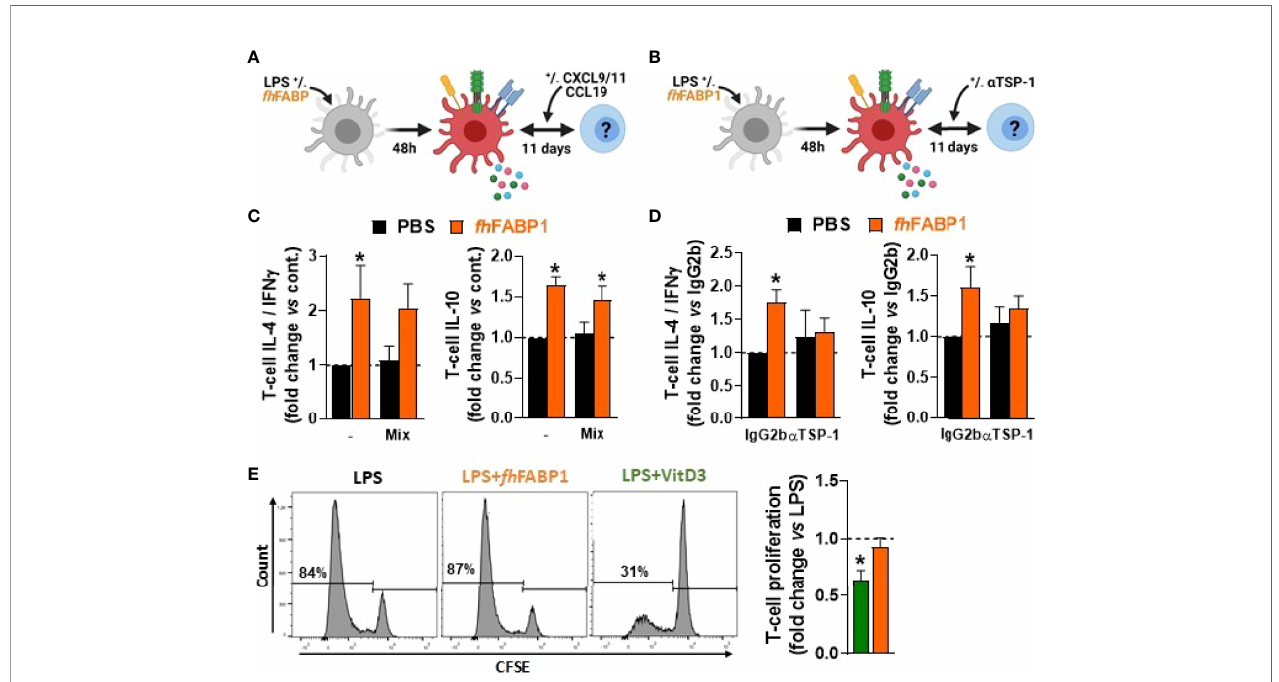
FIGURE 6 | Fasciola hepatica FABP1 modulates dendritic cell-mediated T cell polarization in a thrombospondin 1-dependent manner but does not induce classical regulatory T cells. Human monocyte-derived DCs (moDCs) were treated with or without recombinant fh FABP1 (25 µg/ml) for 48 hours and then co-cultured for 11 days with allogeneic naïve CD4 + T cells in the presence of a chemokine mix (CXCL9, CCL9 and CXCL11 at 033 ng/ml each) (A) or a TSP-1 blocking antibody and IgG2b isotype control (10 µg/ml) (B) Intracellular IL-4, IFN g and IL-10 expression was assayed by fl ow cytometry 6 h after restimulation with PMA and ionomycin, and the IL-4-on-IFN g ratio calculated (C, D) One representative experiment is shown for the Zebra plot The suppressive capacity of T cells induced by fh FABP1- or VitD3-conditioned DCs as described in Figure 4 was assessed by a T cell suppression test (E) One representative experiment from 4 independent experiments is shown for the histogram plots All data are expressed relative to the DCs stimulated with LPS alone (dash line) as mean ± SEM * P ≤ 005 vs LPS alone (n=3-4 independent